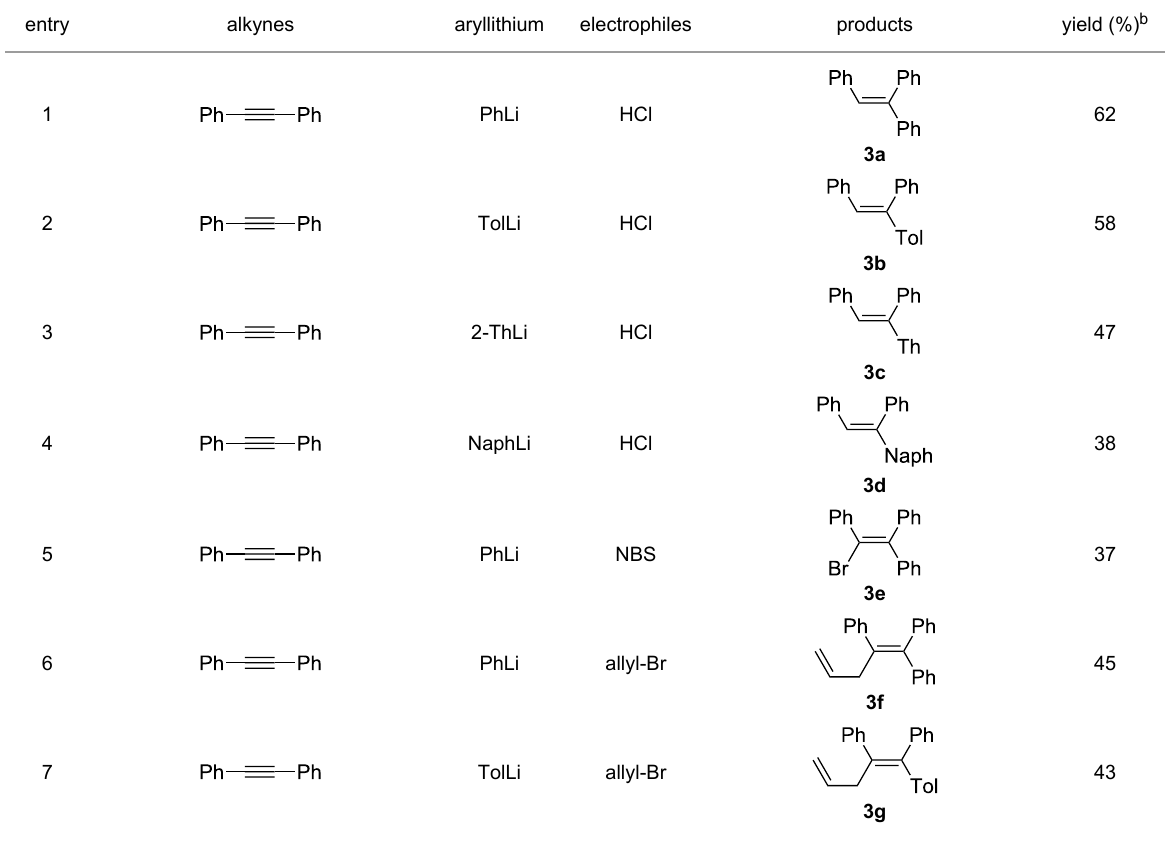
Table 1: Formation of multi-substituted olefins via the reaction of alkynes with [Cp 2 Zr(1-butene)(DMAP)] and aryllithium in the presence of TCQ a .